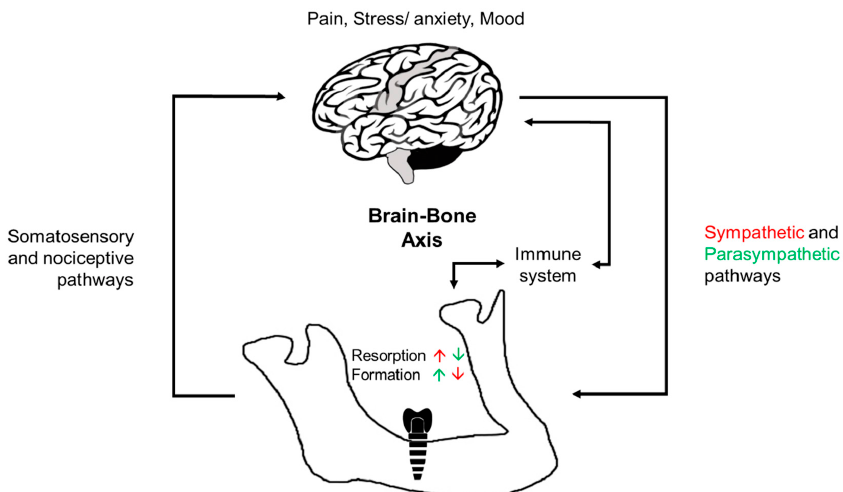
Figure 2. A diagram illustrating brain–bone axis involving the sympathetic and parasympathetic nervous systems that act through direct and direct neuronal innervation of bone tissue (black arrows). Centrally modulated sympathetic activity inhibits osteoblasts and bone formation and enhances osteoclast activity and bone resorption (red), while centrally modulated parasympathetic activity enhances osteoblast activity and bone formation and inhibits osteoclasts and bone resorption (green). Somatosensory and nociceptive inputs from the bone to the brain as well as pain, stress, and mood responses can impact bone formation and resorption either directly through the autonomic nervous system or indirectly through activation of the immune system that can also be activated directly by bone injury.